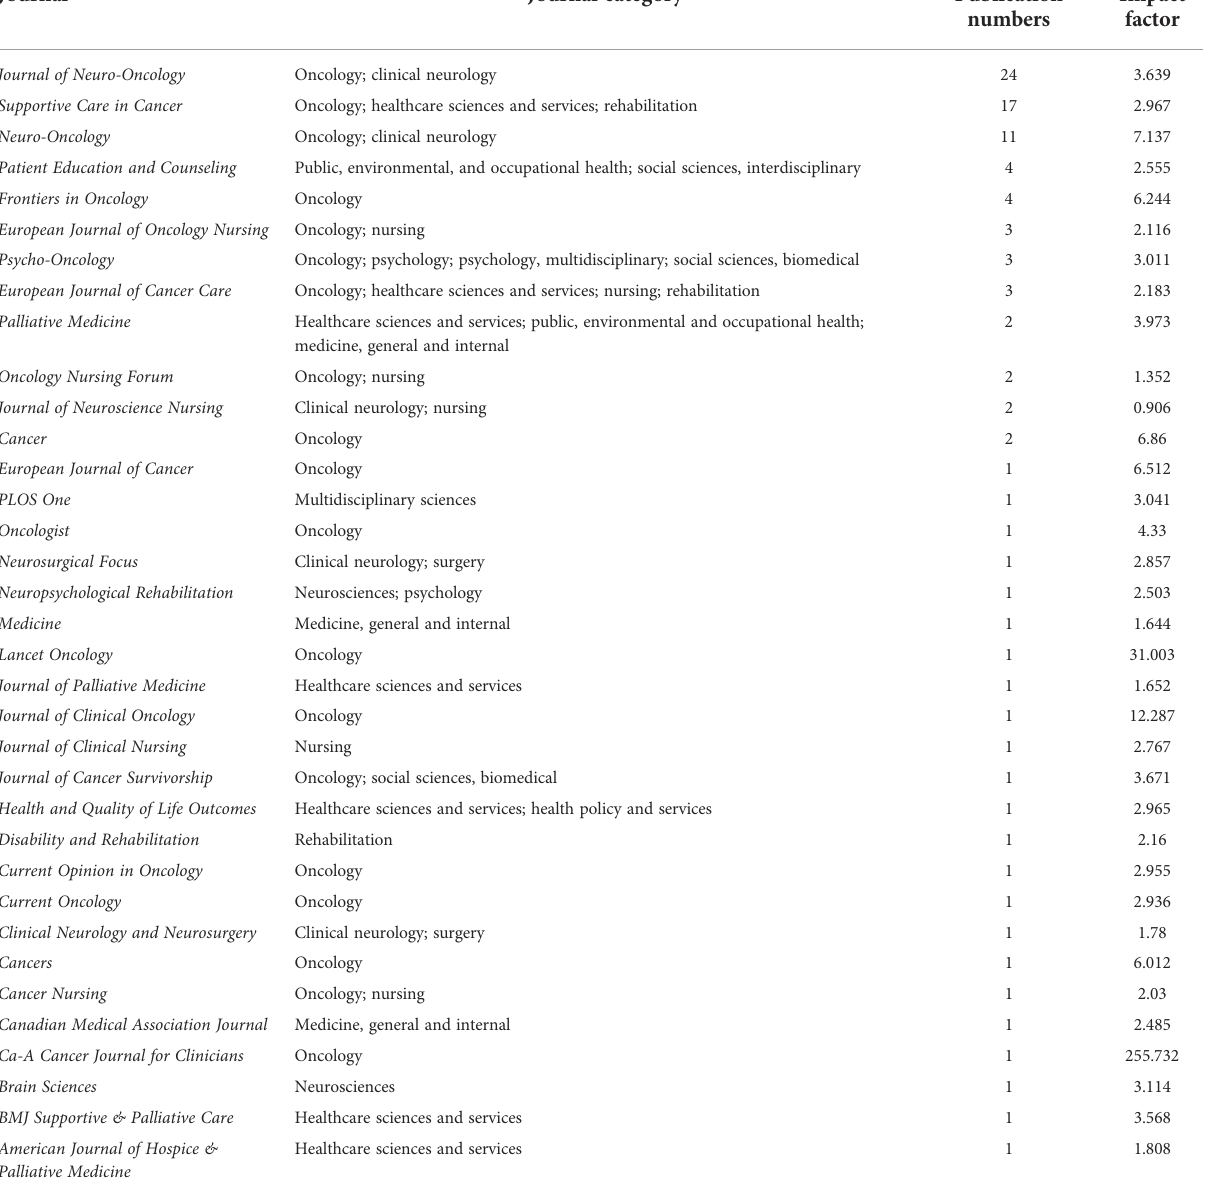
TABLE 1 Journal rankings based on publications of the top 100 cited articles on palliative care for patients with glioma.